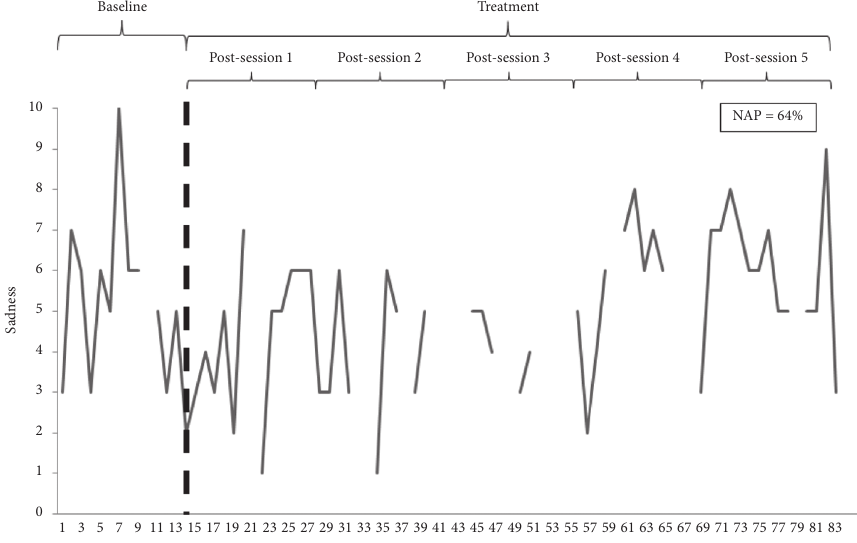
Figure 1: Patient 3 evolution in sadness (moderate improvement). NAP: nonoverlap of all pairs.